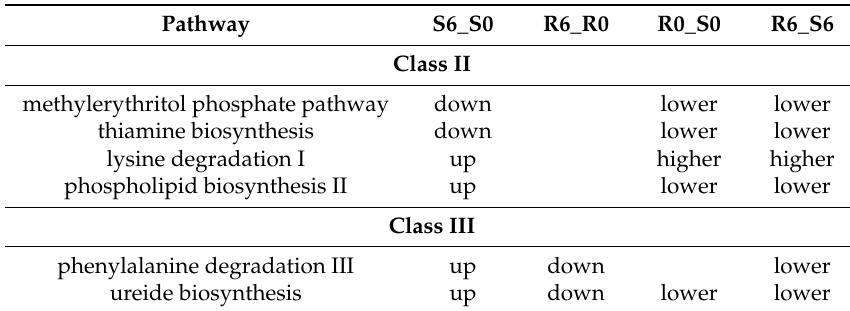
Table 3. The identified SBPH susceptibility-related metabolic pathways and its differential regulation in the four